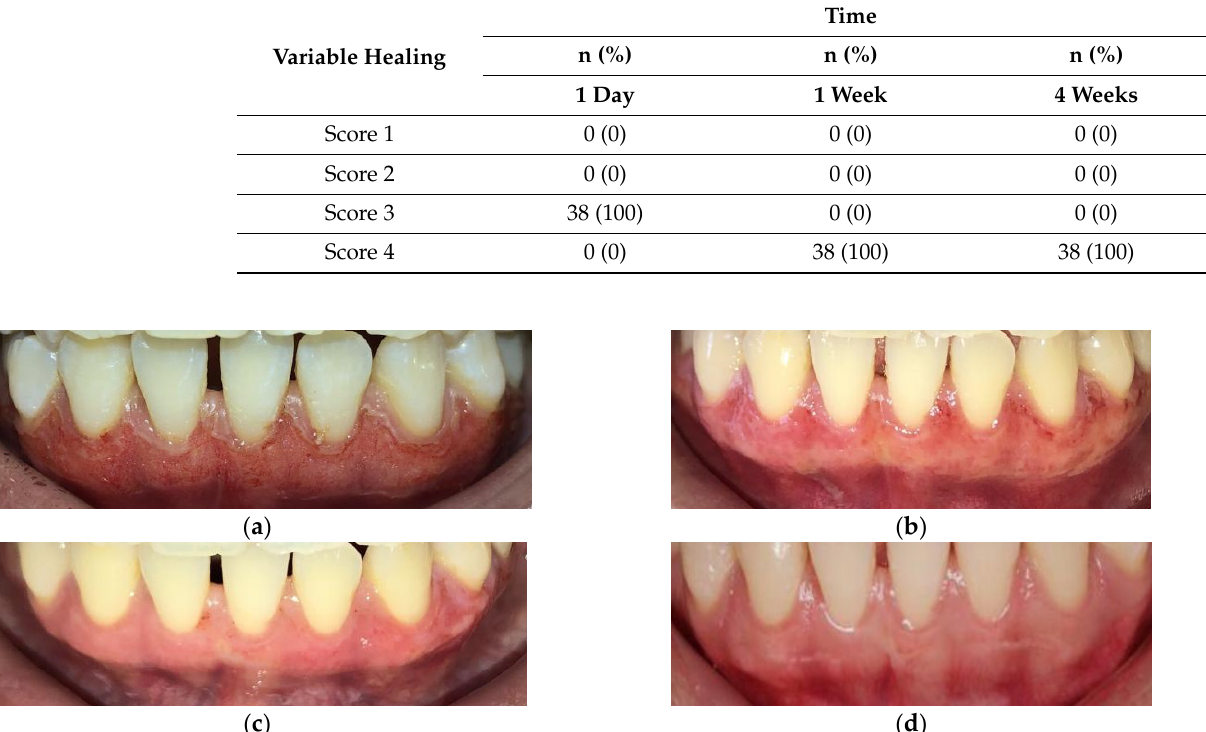
Table 3. Pain at 1 day, weeks 1, 4 and 12 after treatment.